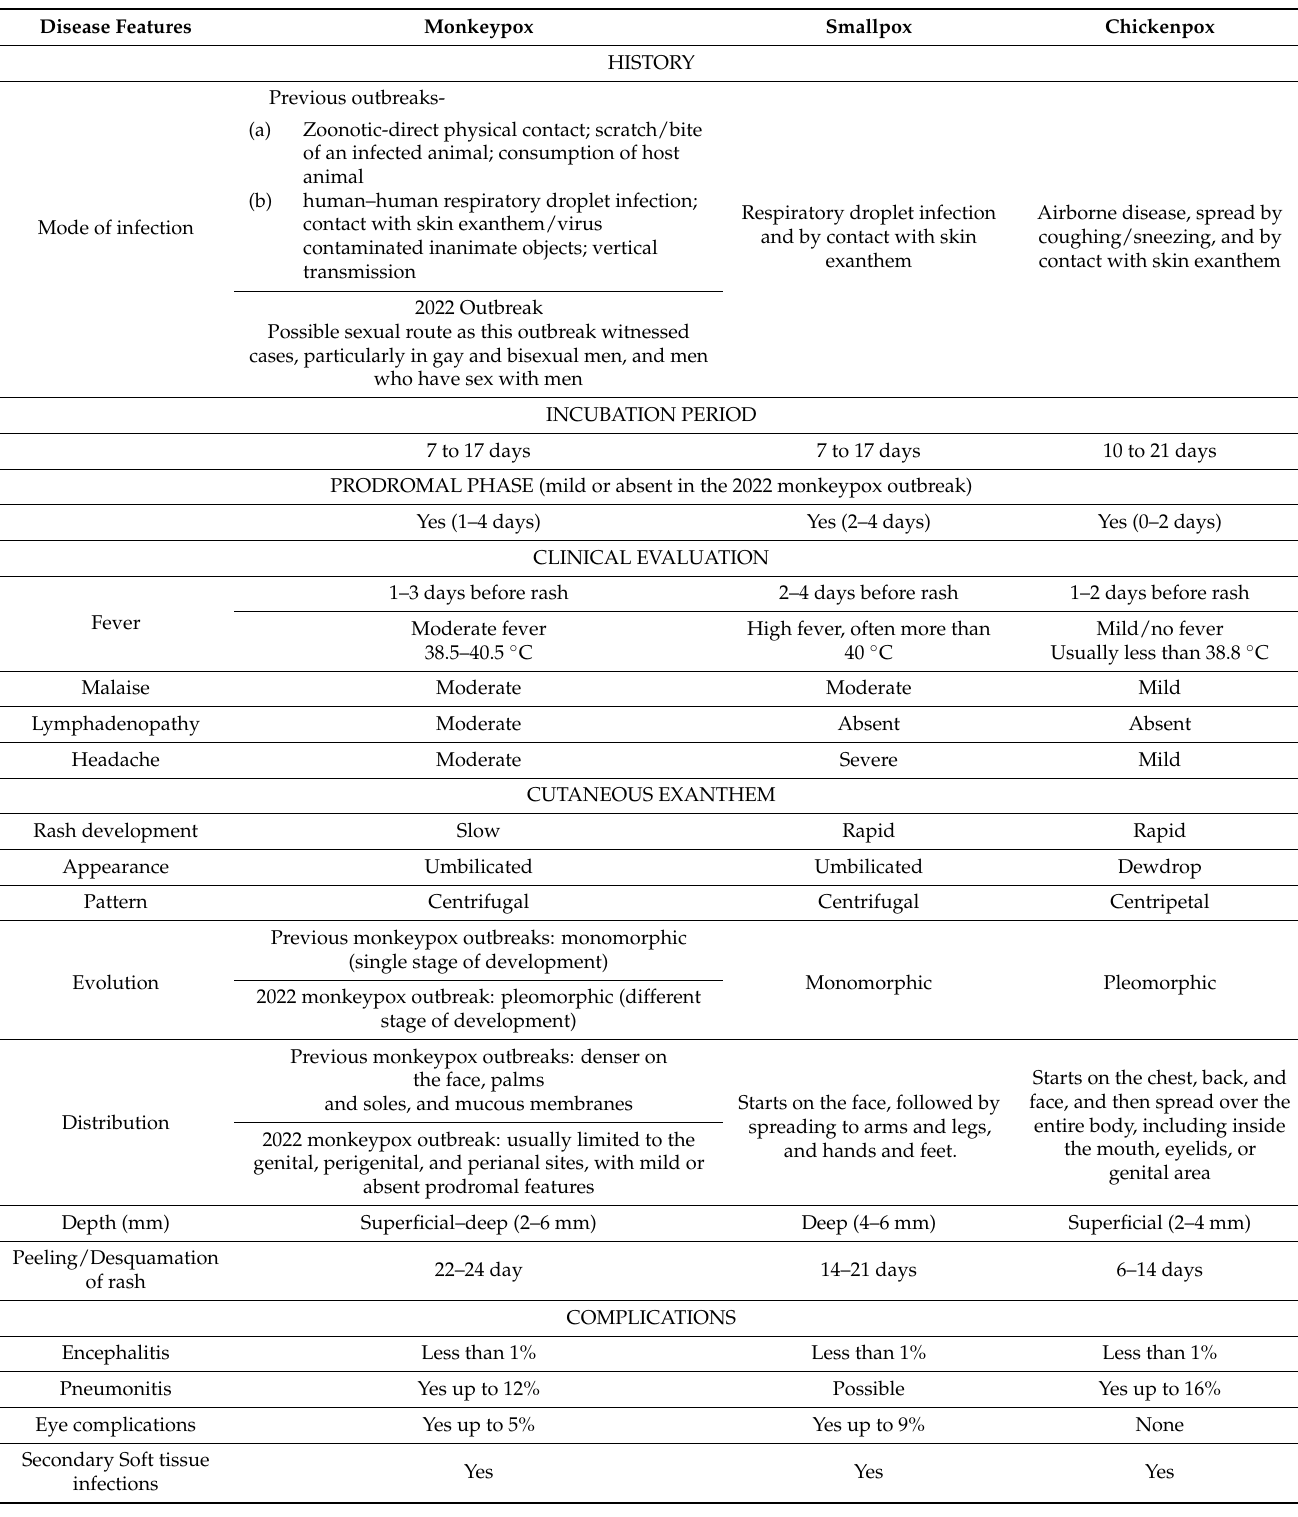
Table 2. Represents the distinguishing features of common rash-associated viral